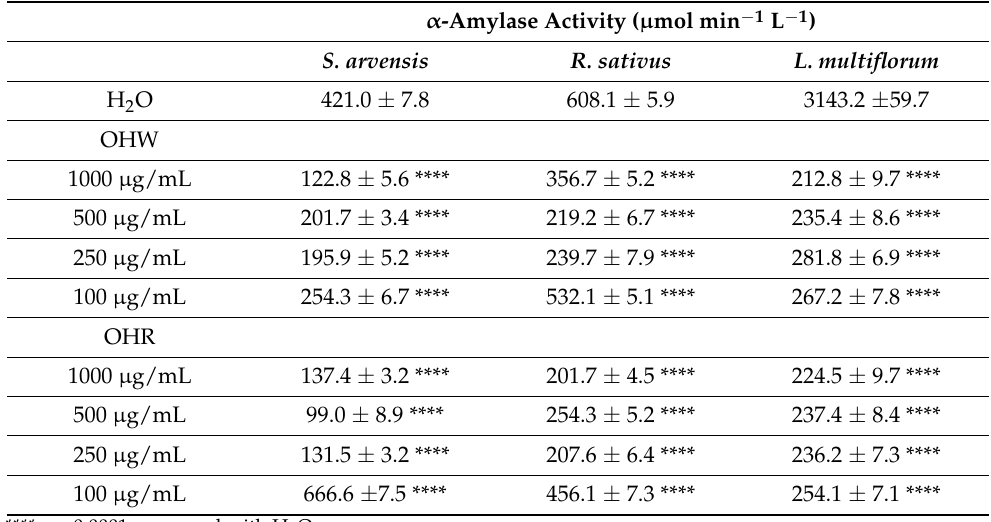
Table 5. α -amylase activity of S. arvensis, R. sativus, and L. multiflorum seedlings at 5 days